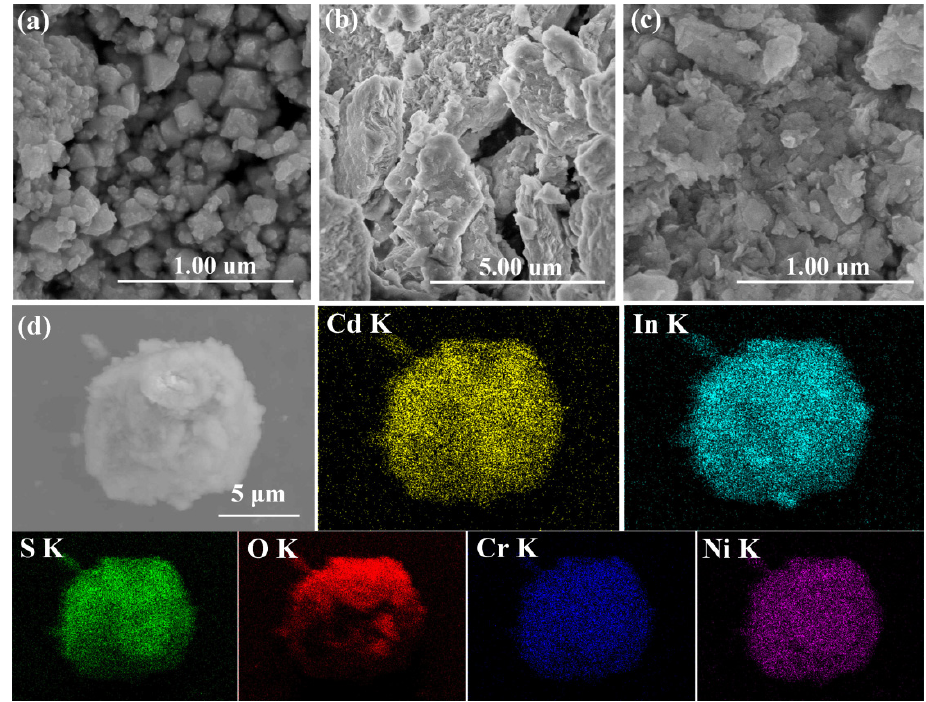
Figure 2. ( a – c ) SEM images of CIS ‐ 4, NC ‐ 180 and HP ‐ 180, ( d ) EDX mapping of Cd, In, S, O, Cr, and Ni elements in HP ‐ 180.